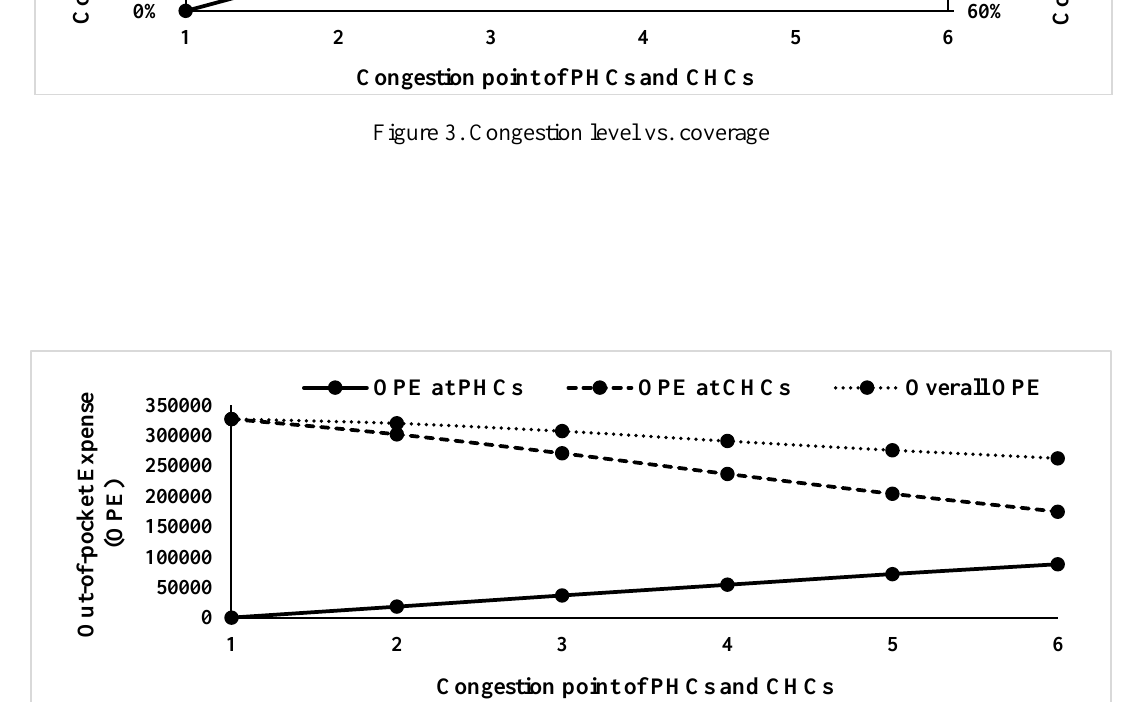
Figure 4. Congestion level vs. out-of-pocket expense